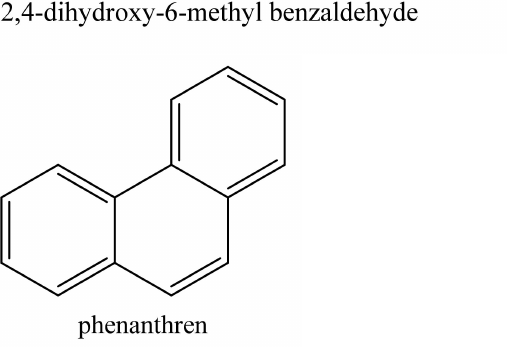
Figure 1. The structures of the compounds of interest in the